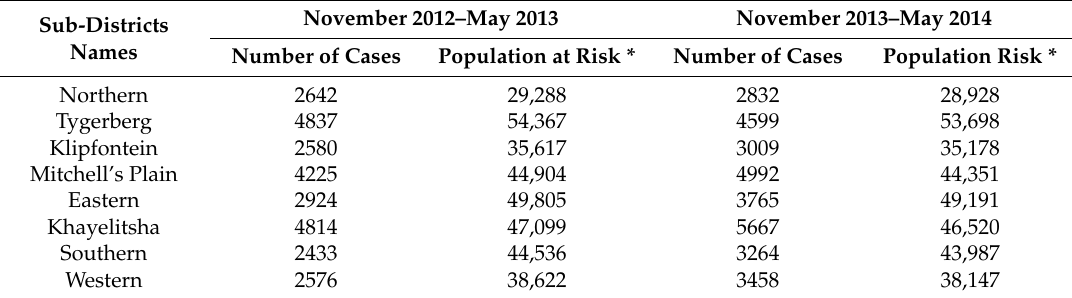
Table 2. Number of cases over a period of seven months (November 2012–May 2013 and November 2013–May 2014) with approximate population at risk in that period by sub-district. These figures were used to calculate incidence of diarrhoea presented in Figure 2.